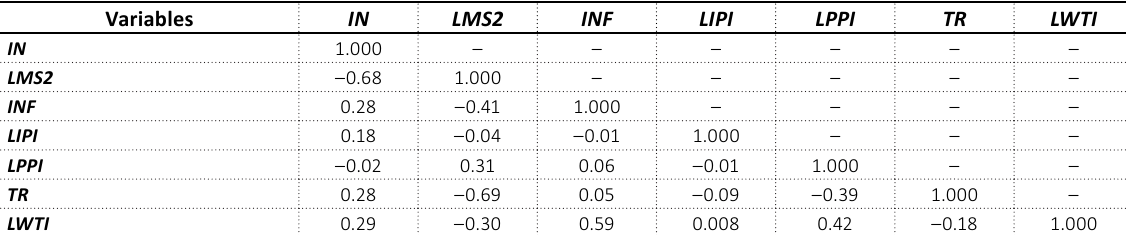
Table 2. Multicollinearity test-correlation matrix